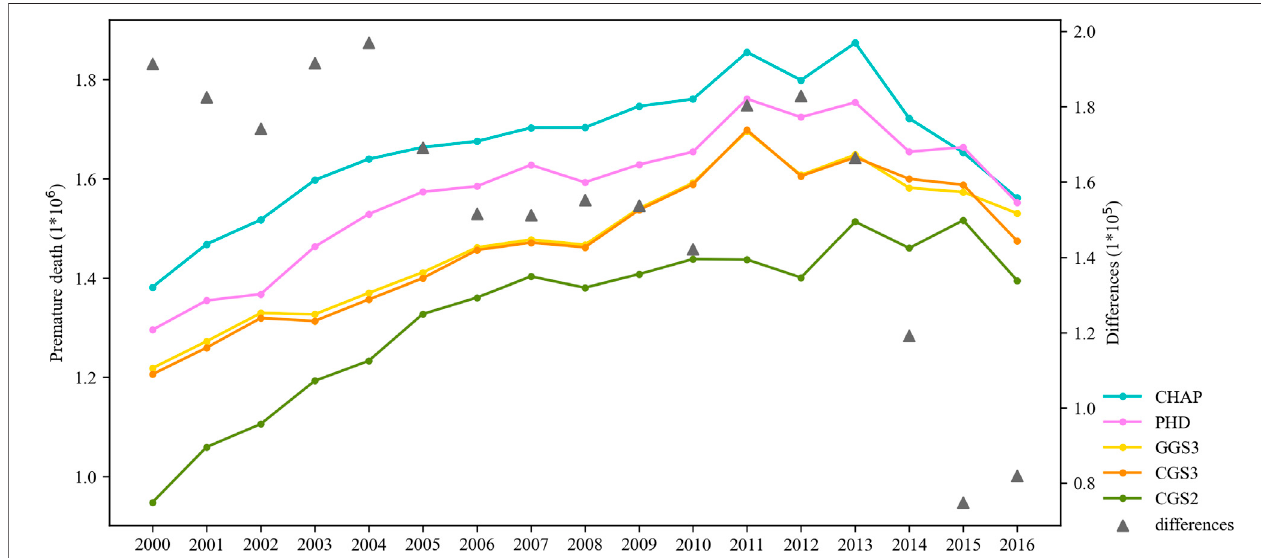
FIGURE 3 | Annual premature deaths were assessed by fi ve sets of PM 2.5 datasets from 2000 to 2016.